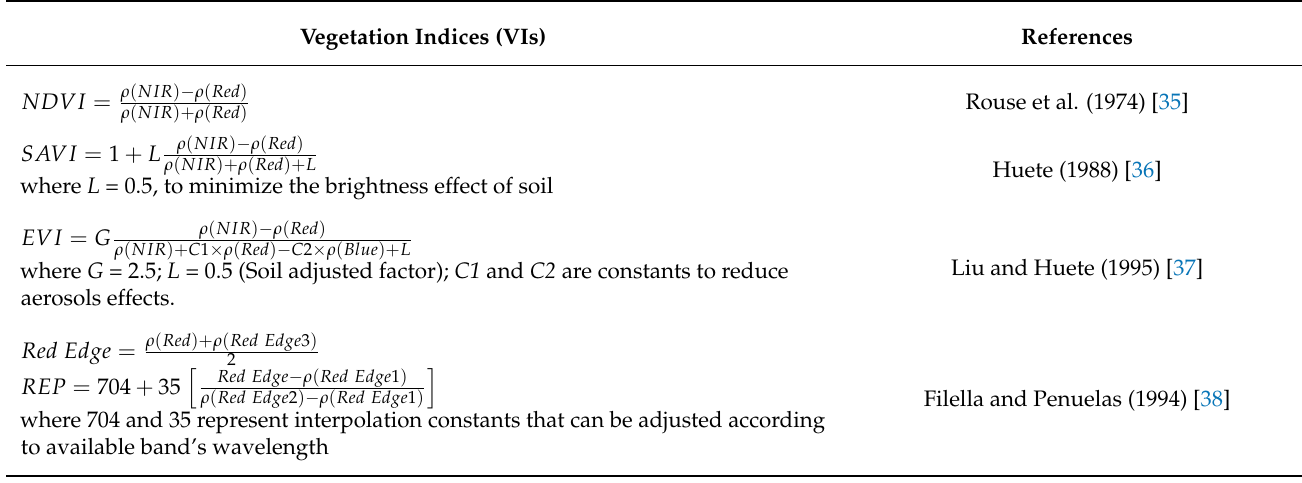
Table 1. Mathematical formulas of vegetation indices (NDVI, SAVI, EVI, and Red Edge Position). Vegetation Indices